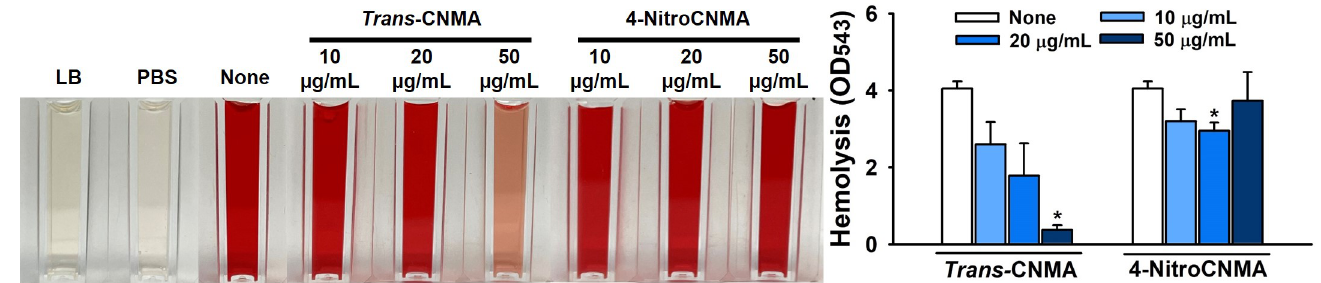
Figure 5. Inhibition of S. aureus induced hemolysis by trans -CNMA and 4-nitroCNMA. Sheep red blood cell hemolysis by S. aureus was investigated in the presence or absence of trans -CNMA or 4-nitroCNMA after culture for 24 h. The images show hemolysis activities in spectrophotometer cuvettes. * p < 0.05 vs. nontreated control (None).